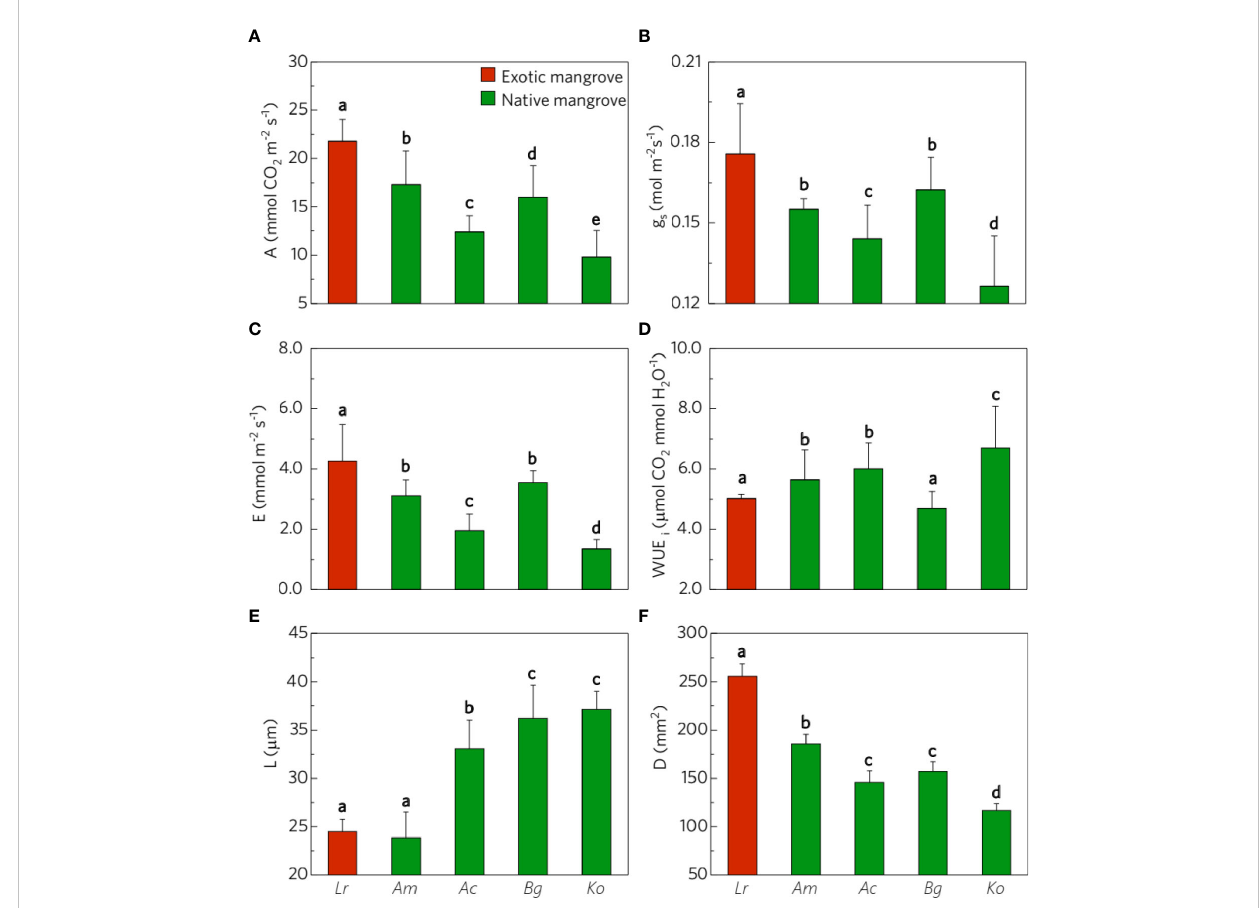
FIGURE 2 Comparison of gas exchange parameters and stomata traits. (A) photosynthesis ( A ), (B) transpiration ( E ), (C) conductance ( g s ), (D) Instantaneous water use ef fi ciency ( WUEi ), (E) stomata guard cell length ( L ), and (F) stomata density ( D ) between exotic mangrove species (red bar) and native mangrove species (green bar), the error bars represent Mean ± SE(n>10), the letters above the bar indicate different signi fi cantly ( p <0.05). See Figure 1 for species abbreviations